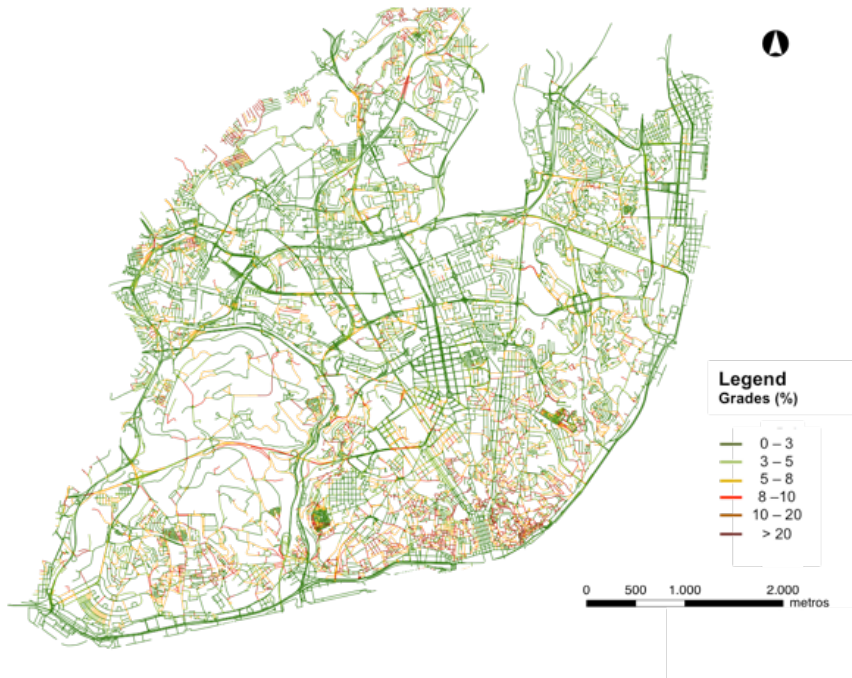
Figure 4. Topography of Lisbon’s road